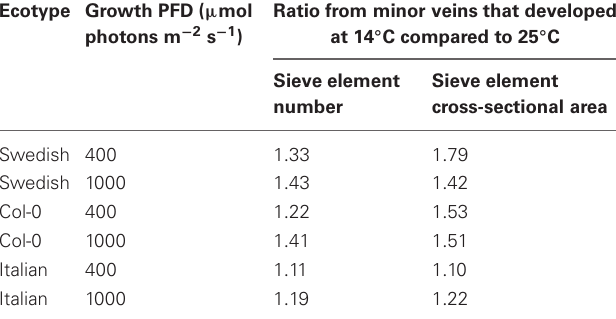
Table 3 | Ratio of total number of sieve elements per minor loading vein and of total sieve element cross-sectional area per minor loading vein from leaves that developed under low temperature (14 ◦ C leaf temperature) vs. under warm temperature (25 ◦ C leaf